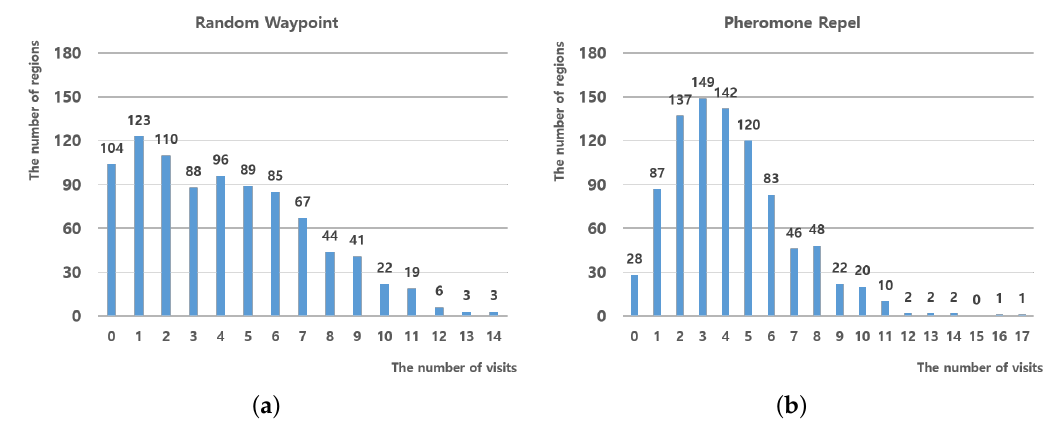
Figure 3. The visited counts: ( a ) Random Waypoint model; and ( b ) Pheromone Repel model.